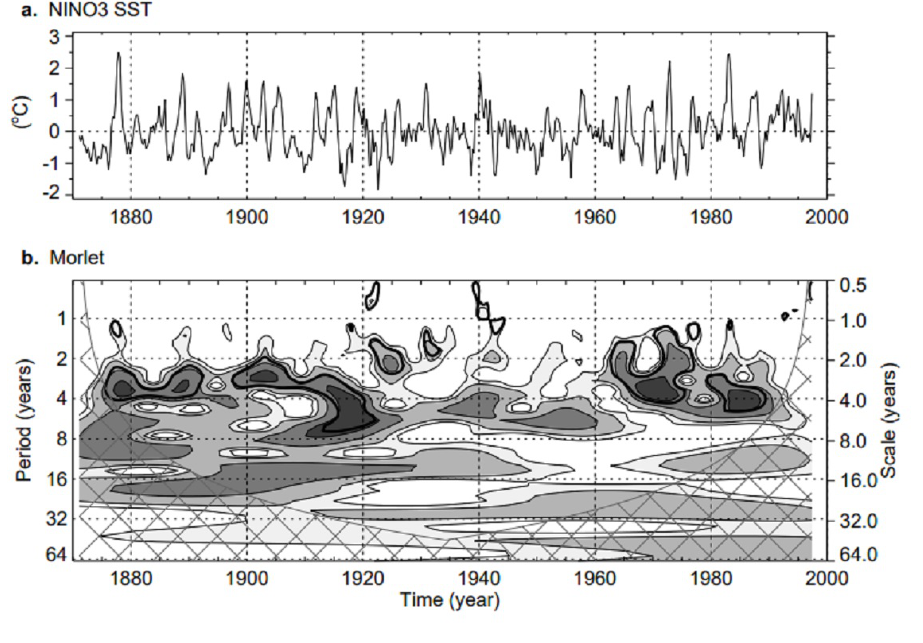
Figure 4. Example for the wavelet transform analysis of the monthly climate temperature (Nino3 SST) time series data: ( a ) The Niño3 SST time series data; and ( b ) the local wavelet power spectrum using the wavelet transform analysis of ( a ) using the Morlet wavelet (Torrence and Compo (1998)